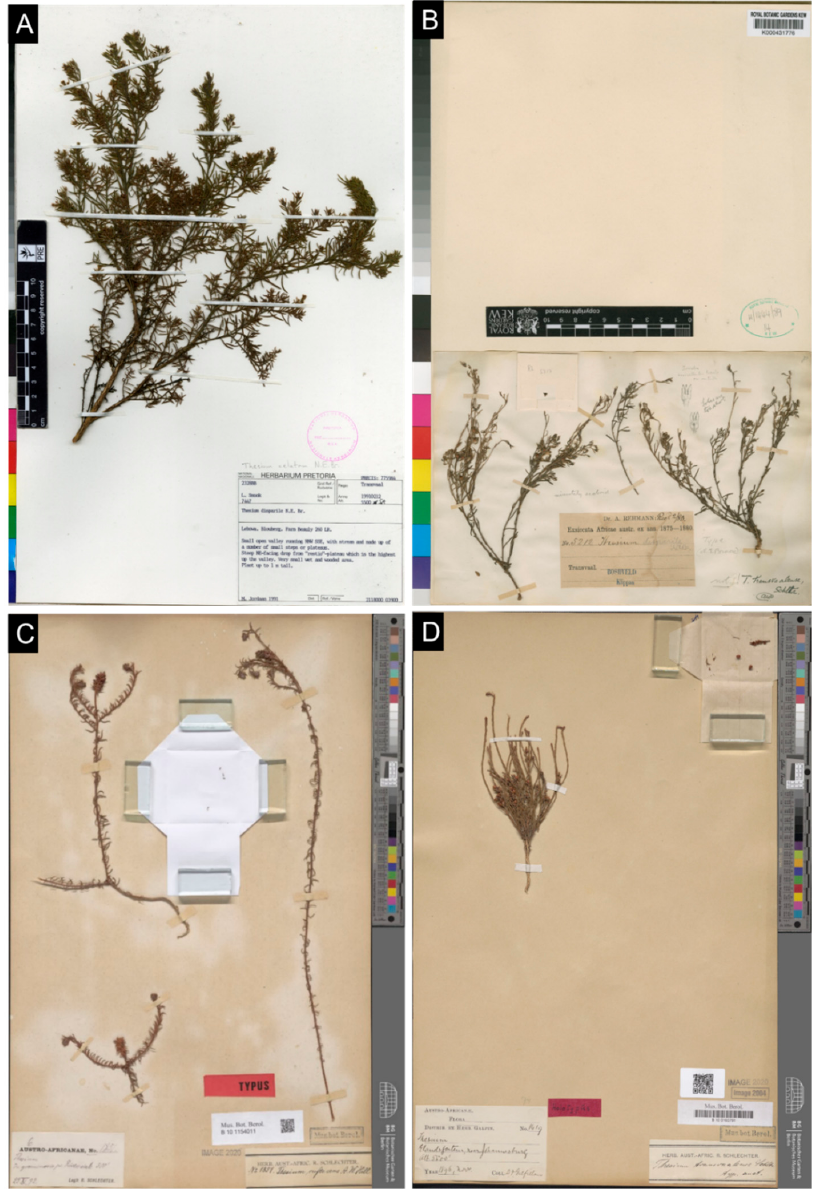
Figure 2. Scans of representative herbarium specimens of Thesium hispidifructum ( A ) and three morphologically similar species T. disparile ( B ), T. rufescens ( C ) and T. transvaalense ( D ). Images reproduced with the consent of the © South African National Biodiversity Institute ( A ); © The Board of Trustees of the Royal Botanic Gardens, Kew ( B ) (http://specimens.kew.org/herbarium/K000431776, accessed on 17 November 2022); and the Botanic Garden & Botanical Museum Berlin, Freie Universität Berlin, Germany ( C , D